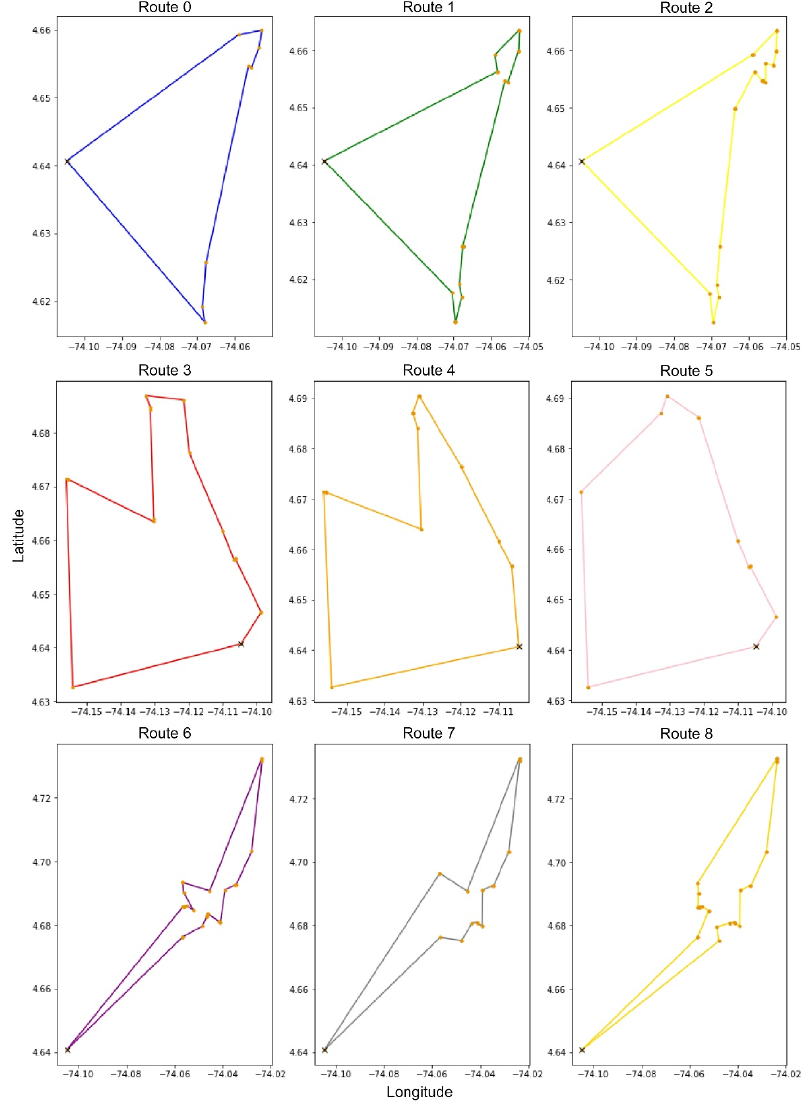
Fig. 7 . Routes details